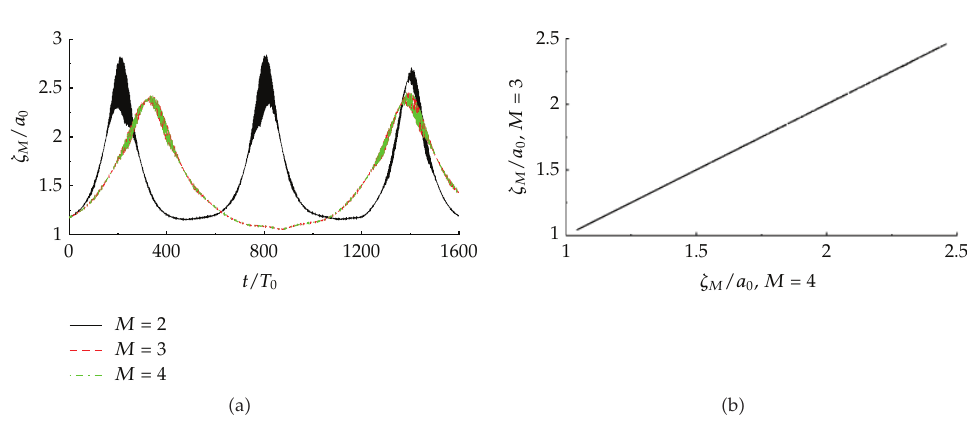
Figure 5: The maximum wave crest histories (cid:2) a (cid:3) and scatter diagram (cid:2) b (cid:3) of Stokes-modulated wave train for ε 0 (cid:7) 0 . 05, r 1 (cid:7) 0 . 1, N (cid:7) 1024, T 0 / Δ t (cid:7) 64 with di ff erent M.